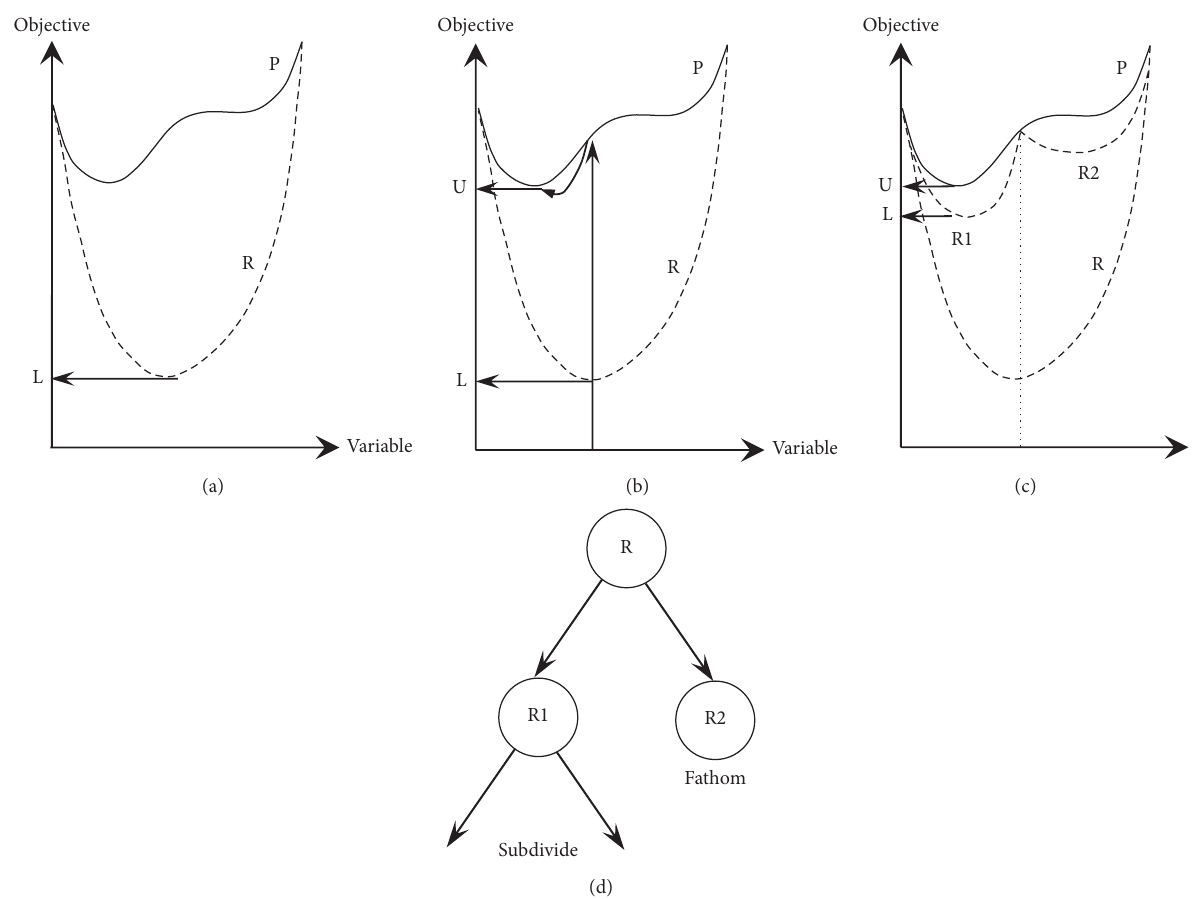
Figure 8: Principles of branch-and-bound [37]. (a) Lower bounding. (b) Upper bounding. (c) Domain subdivision. (d) Search